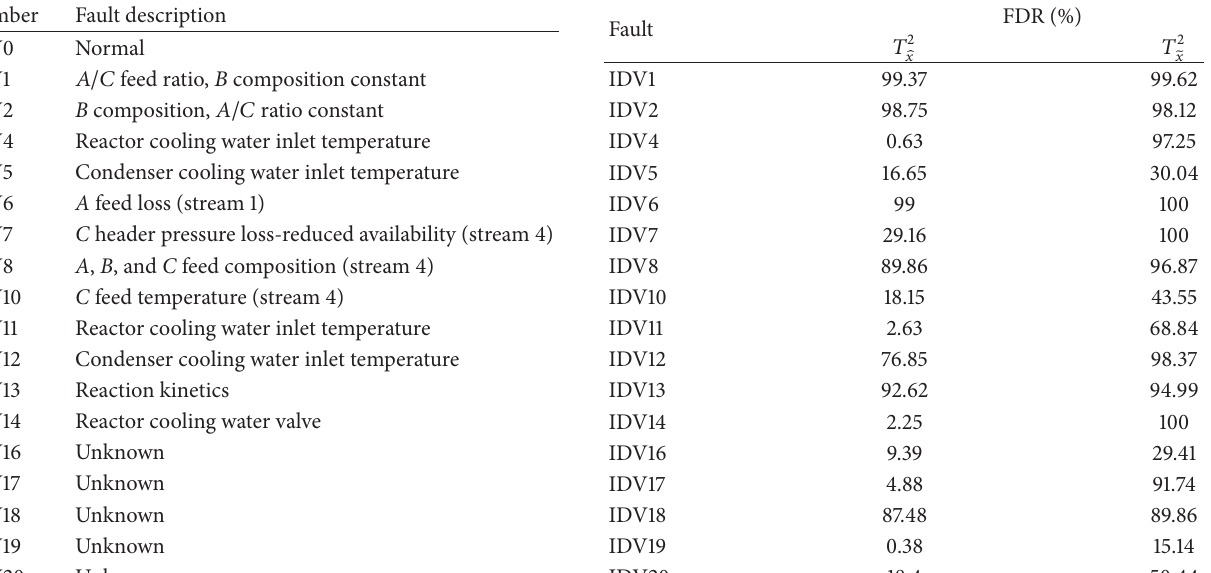
Table 2: Descriptions of 21 faults in TE process.